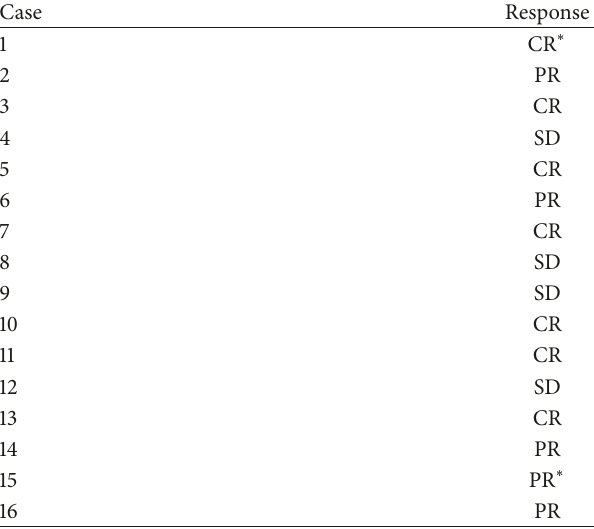
Table 3: Local metabolic tumor response based on 18 F-FDG PET (PERCIST criteria) at 1st follow-up after